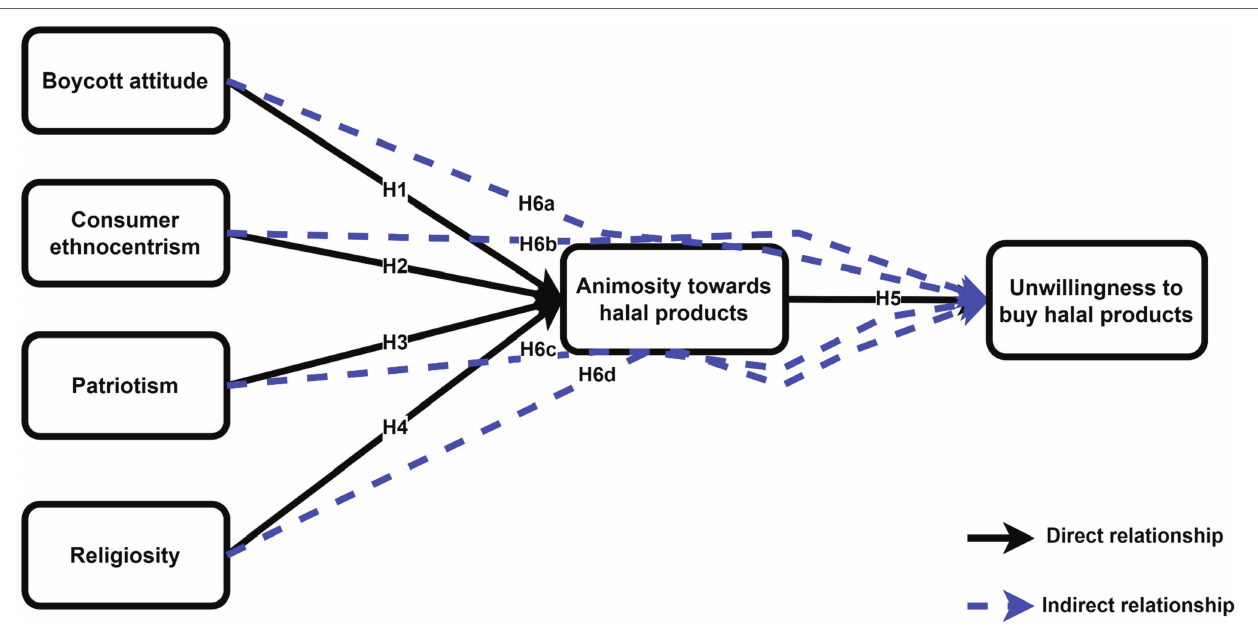
FIGURE 1 | Conceptual framework of the